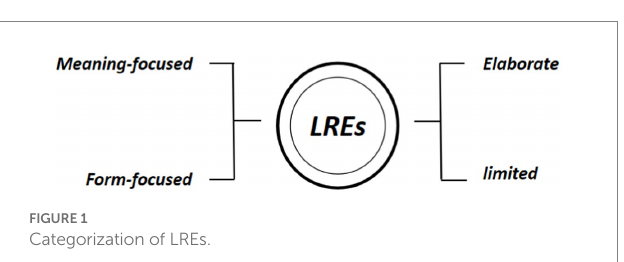
FIGURE 1 Categorization of